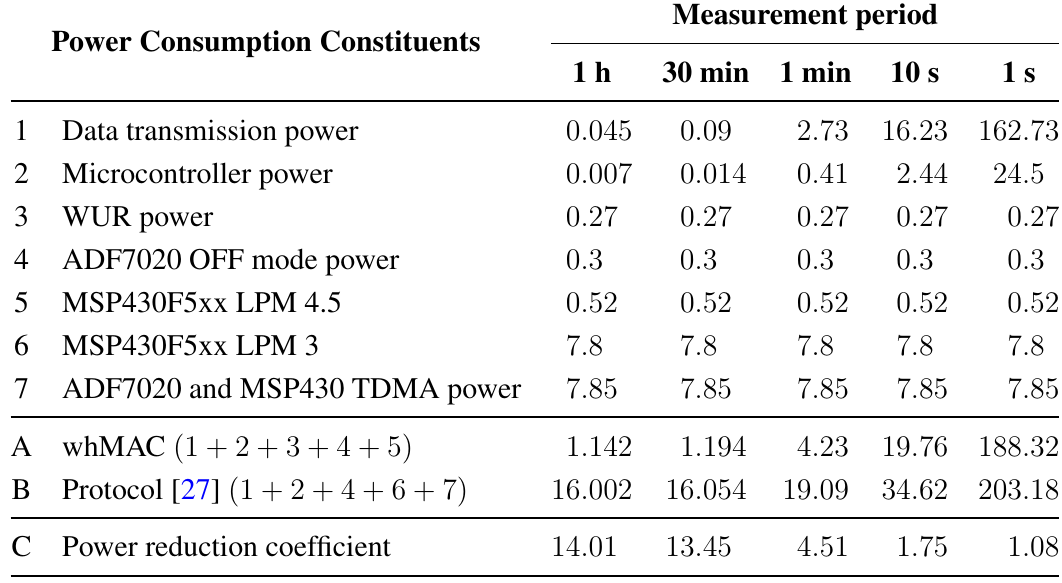
Table 4. Protocol